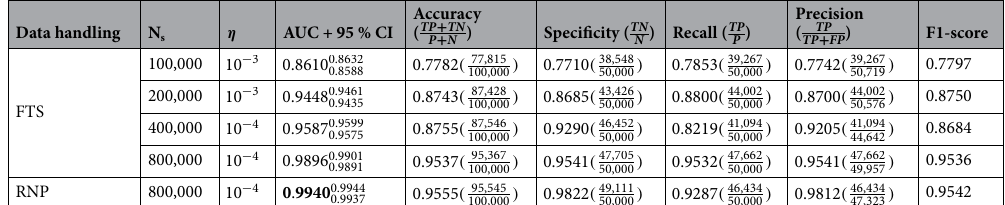
Table 1. Overview of the obtained verification results for our experiments using varying training set sizes N s at different learning rates η . Moreover, different data handling techniques were used ( FTS Fixed training set, RNP Randomized negative pairs). For each experiment, the training sets were balanced with respect to the amount of positive and negative image pairs. In this table, we present the AUC (together with the lower and upper bounds of the 95% confidence intervals from 10,000 bootstrap runs), the accuracy, the specificity, the recall, the precision, and the F1-score. Bold text emphasizes the overall highest AUC